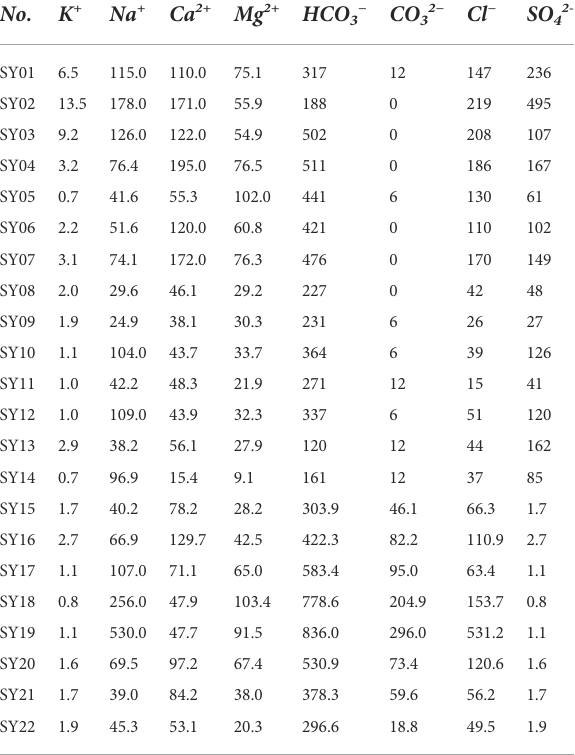
The groundwater buried depth nearby Daxing, Qingyundian (SY20, SY21, and SY22 in Table 2) is < 4 m. Due to the function of vadose soil capillarity and evapotranspiration, the shallow